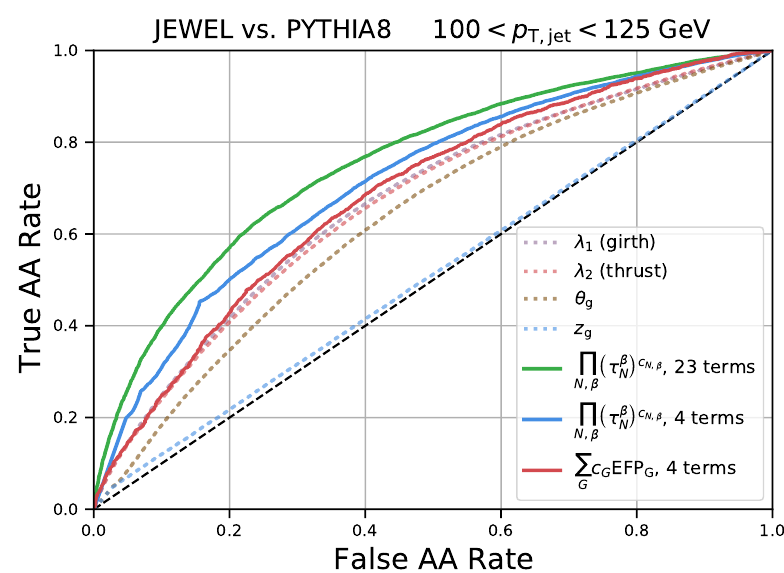
Figure 7 . ROC curves for the Lasso regression using the N -subjettiness basis and EFPs. For comparison we also show the result for typical observables in heavy-ion